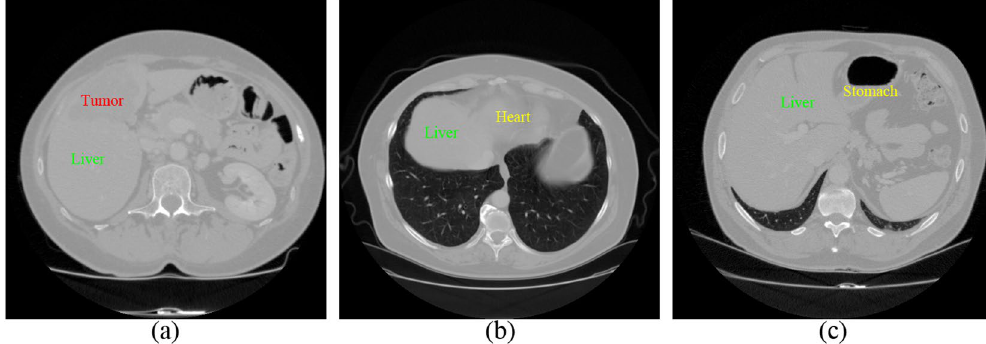
Figure 1. Examples of the limiting factors for liver segmentation in CT images. ( a ) Demonstrates intensity inhomogeneity between liver and tumor. ( b ) and ( c ) display that liver, heart, and stomach share similar intensity